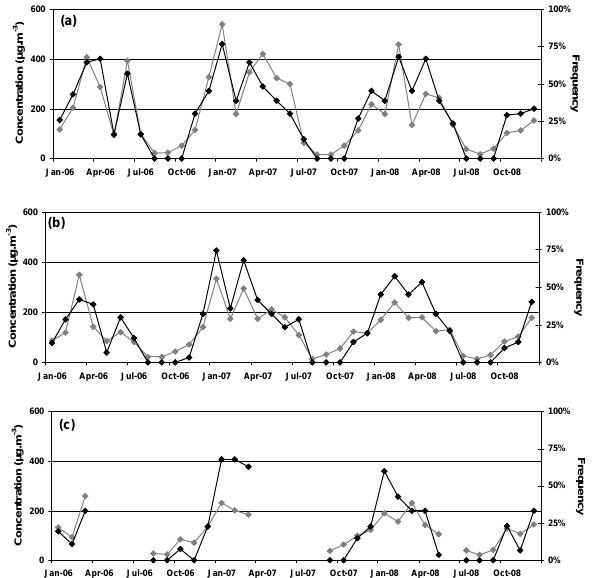
Fig. 8. Monthly mean concentrations (black) and monthly frequen- cies of daily concentrations higher than 150µgm − 3 (grey) in Ban- izoumbou (a) , Cinzana (b) and M’Bour (c) from January 2006 to December 2008 (For M’Bour, values are given only if the number of daily data per month is higher than 15).